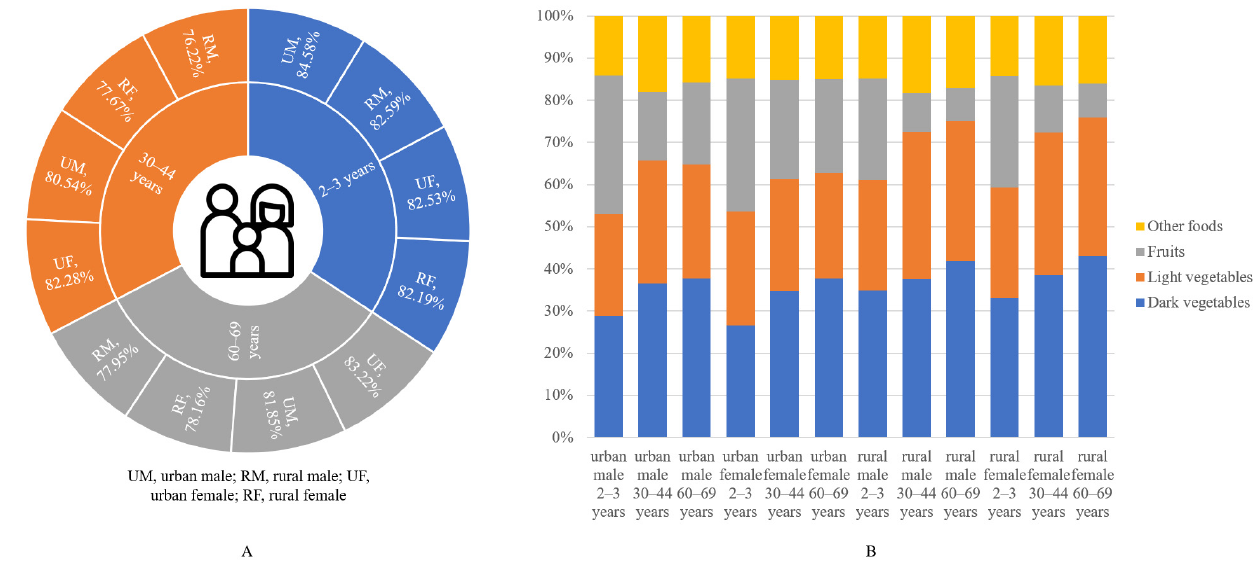
Figure 4. Contribution to dietary exposure of different consumer groups of ( A ) metalaxyl-M and azoxystrobin and ( B ) major food categories.